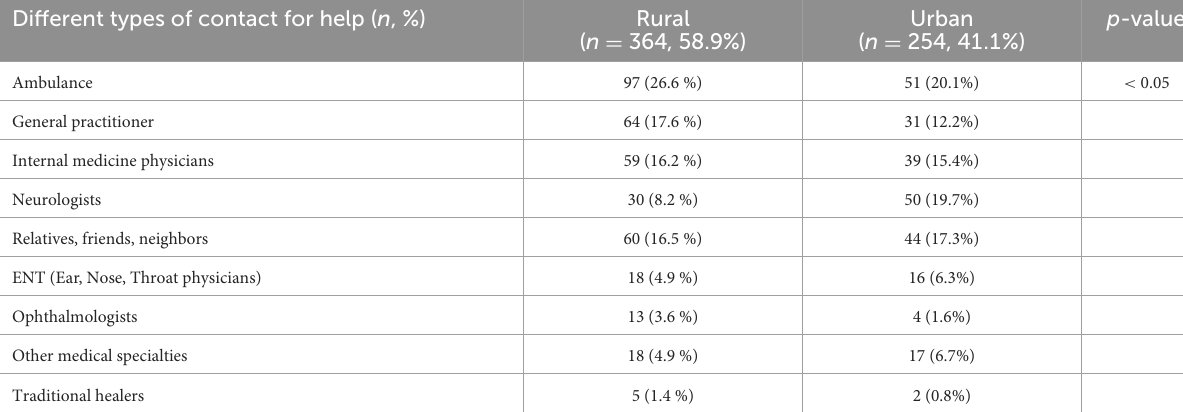
TABLE 2 Type of help-seeking behaviors among the study population. Different types of contact for help ( n ,